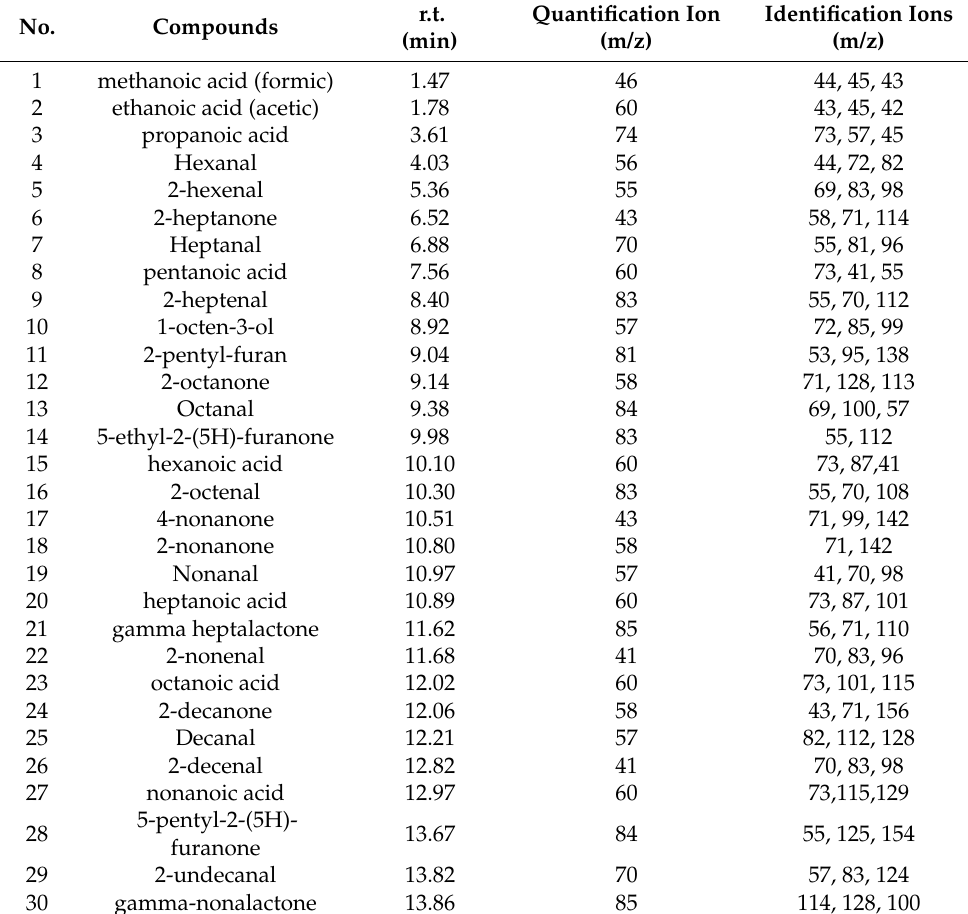
Table 2. Compounds emitted by all sets of